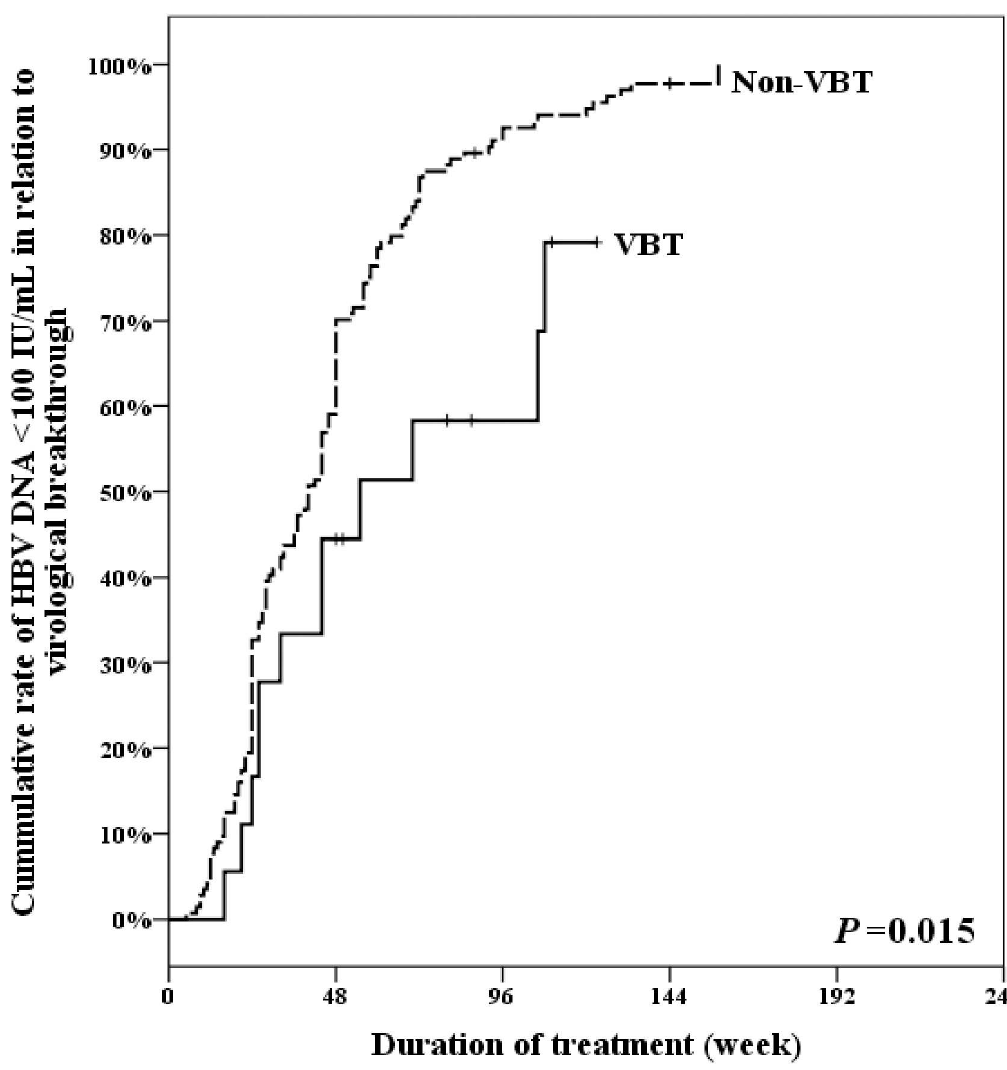
Fig 2. Cumulative rate of HBV DNA < 100IU/mL in relation to virological breakthrough. VBT: virological